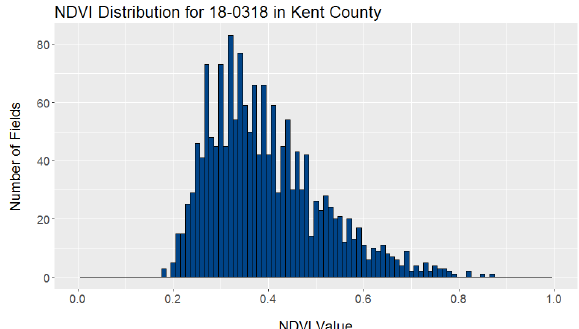
Figure 7. NDVI histogram of enrolled fields in Kent County, Landsat imagery on March 18, 2018. Date is displayed as YY- MMdd.